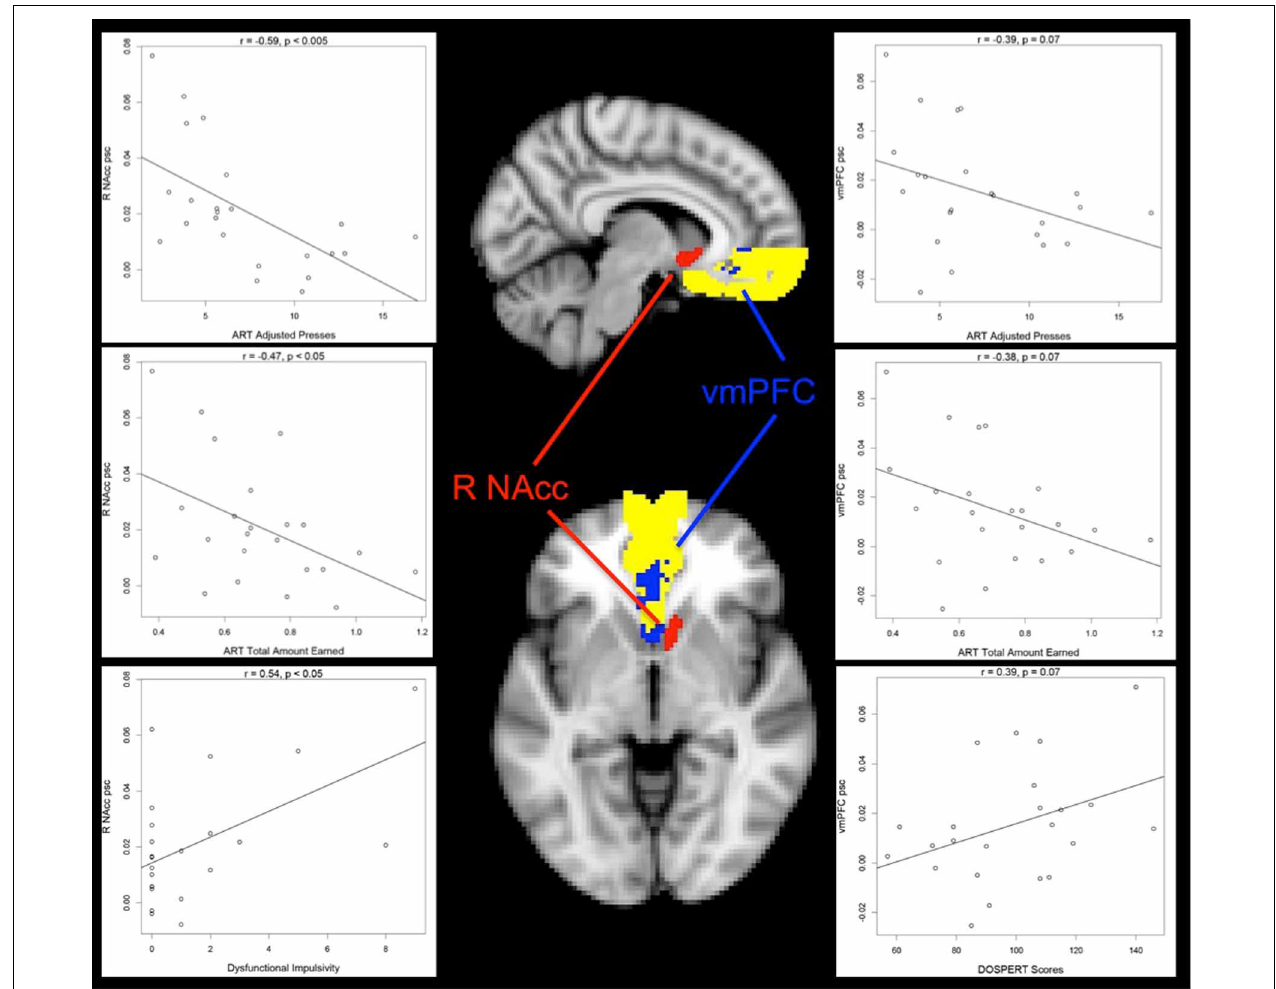
FIGURE 5 | Relationship between risk-taking performance, impulsivity, risk-taking propensity and Risky choice Parametric activation. Average percent signal change (psc) values extracted from the right nucleus accumbens (R NAcc) negatively correlate with ART average Adjusted Presses (top left panel) and Total Amount Earned (middle left panel), and positively correlate with Dysfunctional Impulsivity scores (bottom left panel), suggesting that increased reward-tracking activation is associated with poorer performance on the ART and higher impulsivity. A similar pattern is seen in average percent signal change (psc) values extracted from the ventromedial prefrontal cortex (vmPFC), although at trend level: vmPFC activation negatively correlates with ART average Adjusted Presses